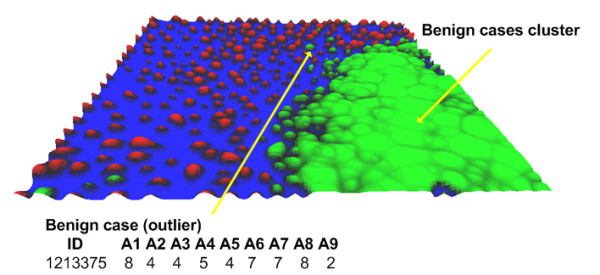
Example of self organizing map (associative memory). Each one of the 9-dimensional, 683 individual cases is associated with a region on the 2-dimensional map and highlighted using a 3rd dimension (an "activation bubble" with elevation and colour). The organization of individual descriptions of cases obeys similarity principles: similar cases are closely mapped and very similar cases form clusters (e.g., the green area contains most of the benign cases).